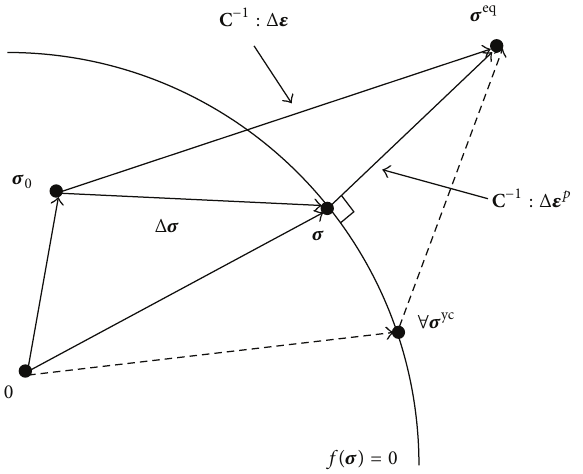
Figure 1: The closest-point projection method.